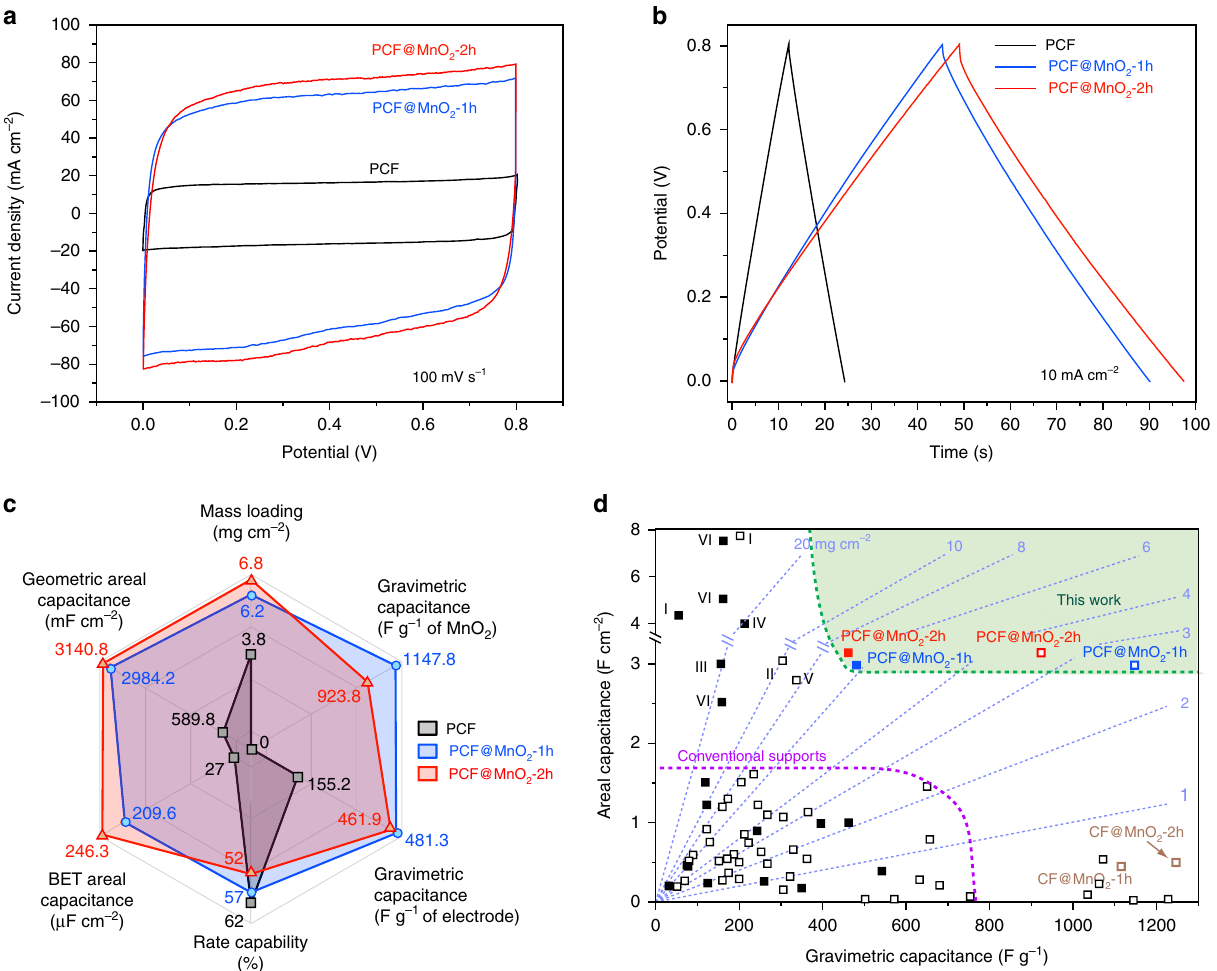
Fig. 6 Electrochemical performance of PCF, PCF@MnO 2 -1h and PCF@MnO 2 -2h. a CVs at a scan rate of 100 mV s − 1 . b Galvanostatic charge-discharge curves at 10 mA cm − 2 of PCF (black), PCF@MnO 2 -1h (blue), and PCF@MnO 2 -2h (red). c The radar chart compares the six fi gure-of-merits of PCF (black), PCF@MnO 2 -1h (blue), and PCF@MnO 2 -2h (red): mass loading of the active materials, rate capability (from 10 to 1000 mV s − 1 ), gravimetric capacitance based on the mass of MnO 2 and the active materials, and areal capacitance based on the geometric area and BET surface area. All capacitances are obtained at 10 mV s − 1 . d Mass loading, gravimetric capacitance, and geometric areal capacitance of PCF-based electrodes in comparison with other reported electrodes. Dashed lines mark the mass loadings in mg cm − 2 . Open and fi lled squares are capacitances based on the mass loadings of MnO 2 and the entire electrodes, respectively. Note that the open (and fi lled) squares are only to be compared with open (and fi lled) squares. The labeled points: I, wood-derived porous carbon@MnO 2 ; 14 II, hierarchical MnO 2 on carbon cloth; 12 III, carbon nanotube (CNT)@MnO 2 ; 60 IV, activated